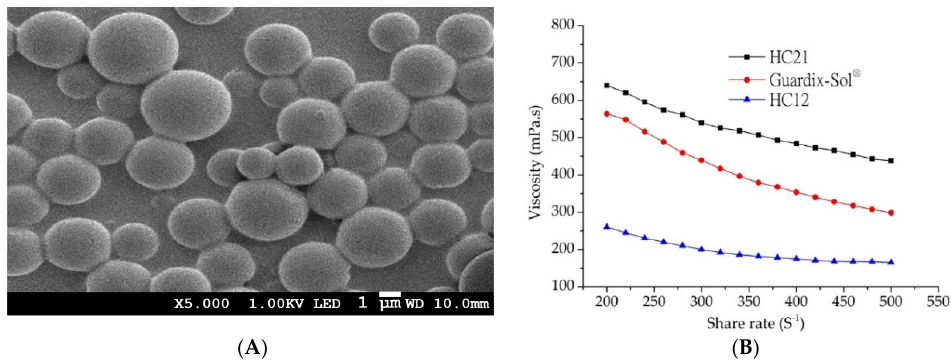
Figure 2. ( A ) SEM image of oxaliplatin-PLGA microparticles (at X5.000 magnification); (B) rheology properties of hydrogel samples ( ■ ) HC21, ( ● ) Guardix-Sol ® , and ( ▲ ) HC12 (measurements were properties of hydrogel samples ( (cid:4) ) HC21, ( (cid:8) ) Guardix-Sol ® , and ( (cid:78) ) HC12 (measurements were performed at 37 ± 0.5 ° C ) . performed at 37 ± 0.5 ◦